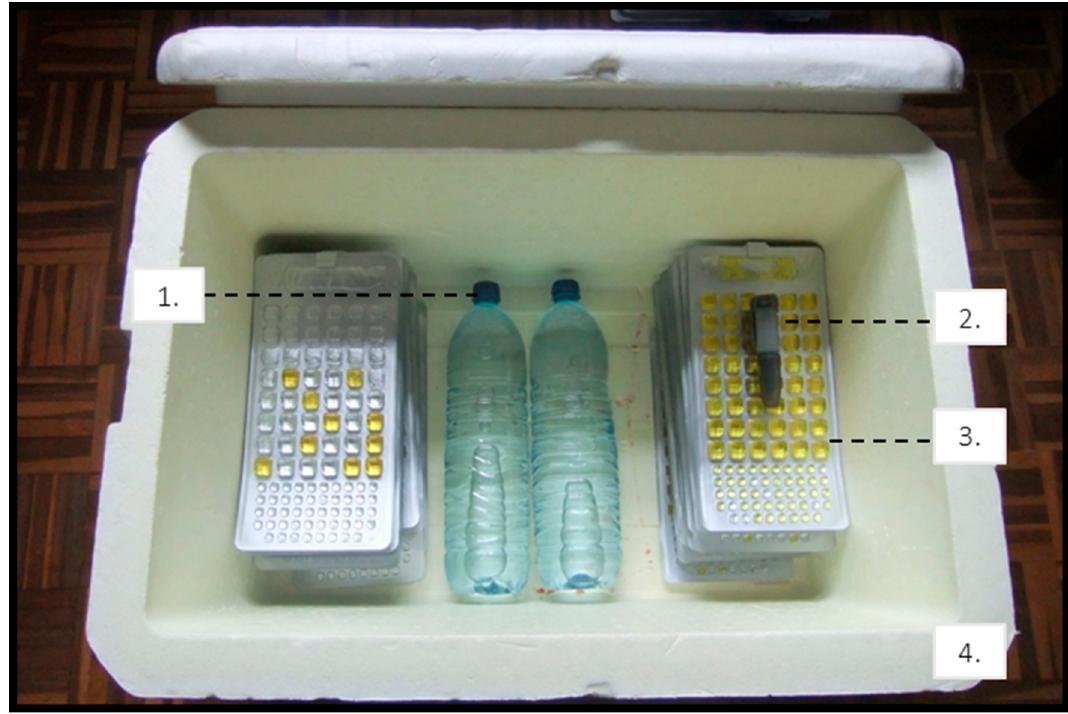
Figure 1. The expanded polystyrene (EPS) incubator with Colilert trays and 1.5 L polystyrene bottles with heated water. Labels: 1. Polystyrene bottles, filled with water; 2. Temperature data logger; 3. Colilert trays; 4. EPS foam cooler.